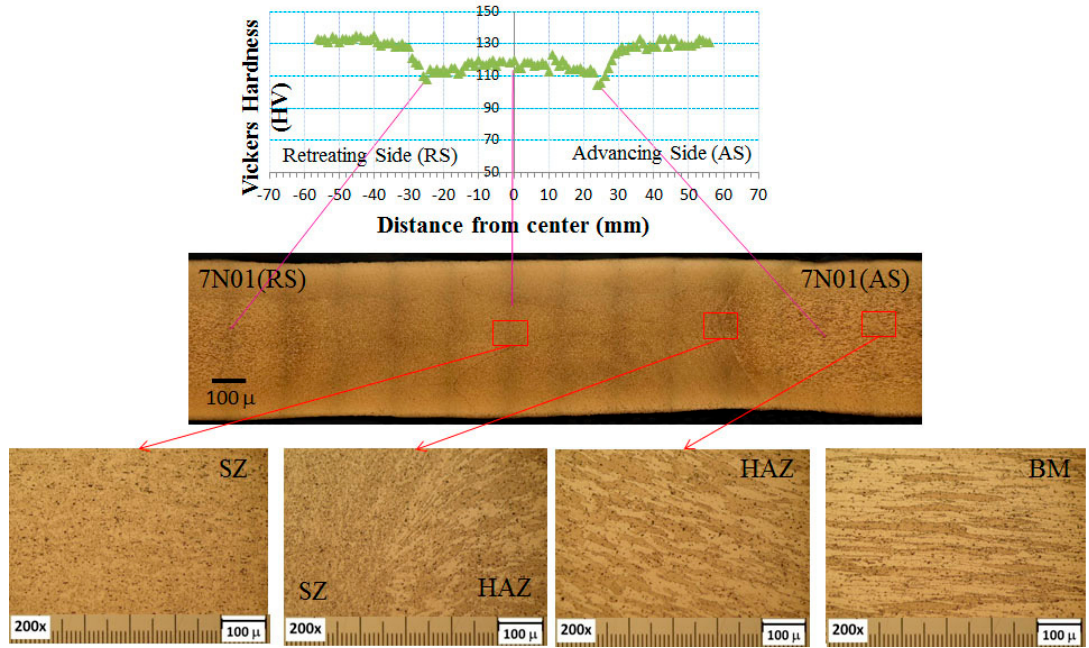
Figure 5. Microstructure and hardness distribution for the 7N01 friction stir welding (FSW).